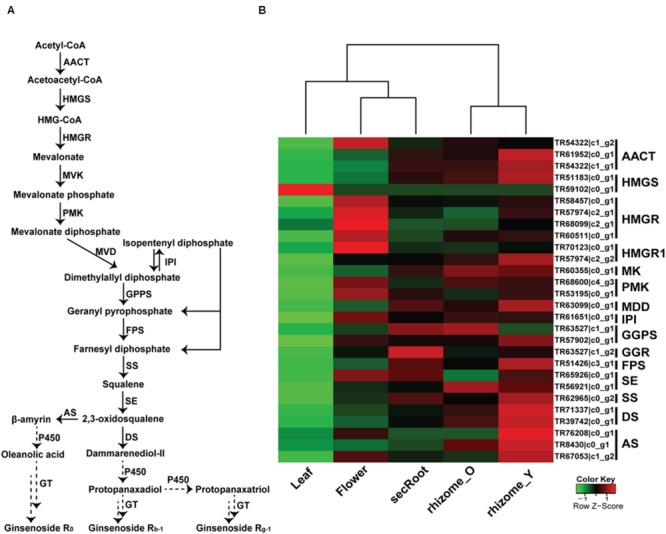
Putative triterpenoid saponins biosynthesis pathway and expression level of associated unigenes across five tissues in P. japonicus. (A) Proposed pathway for triterpenoid saponins biosynthesis. (B) Expression levels of the candidate unigenes that showed high sequence similarity with other Panax species, and were annotated as enzyme coding genes from triterpenoid backbone biosynthesis pathways. The expression value (FPKM) for unigenes across all tissues were log2 transformed and scaled across each row, and heatmap was generated using R-package heatmap2.0. AACT, Acetyl-CoA acetyltransferase; HMGS, hydroxymethylglutaryl-CoA synthase; HMGR, hydroxymethylglutaryl-CoA reductase; MVK, mevalonate kinase; PMK, phosphor mevalonate kinase; MVD, mevalonate diphosphate decarboxylase; IPI, isopentenyl diphosphate isomerase; GPPS, geranylgeranyl pyrophosphate synthase; FPS, farnesyl diphosphate synthase; SS, squalene synthase; SE, squalene epoxidase; DS, dammarendiol synthase; AS, beta-amyrin synthase; GTs, UDP glycosyltransferase; P450, cytochrome P450; FPKM, fragments per kilobase per million.